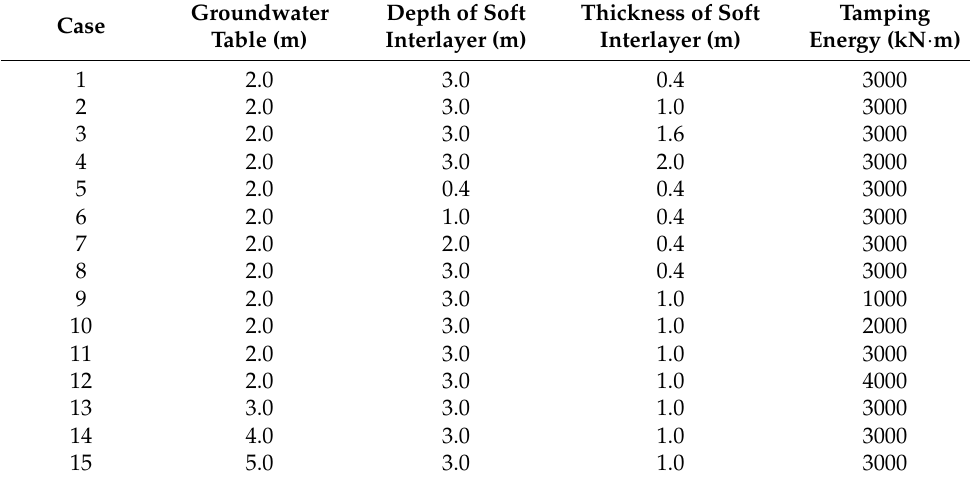
Table 4. Summary of influence factor for foundation with or without an embedded weak layer. Groundwater Depth of Soft Case Table (m) Interlayer